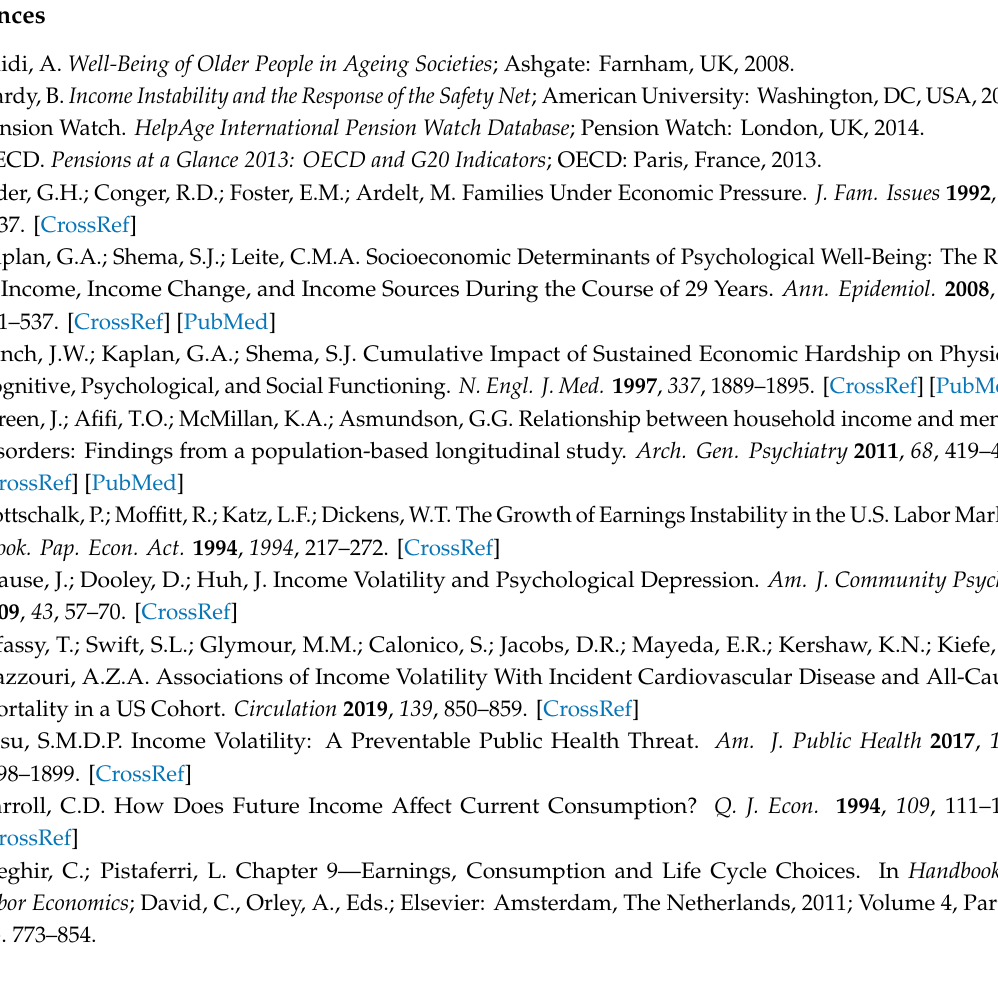
s1, Table S1: Bivariate correlation, Table S2: The relationships of income volatility to depressive symptoms (sensitivity